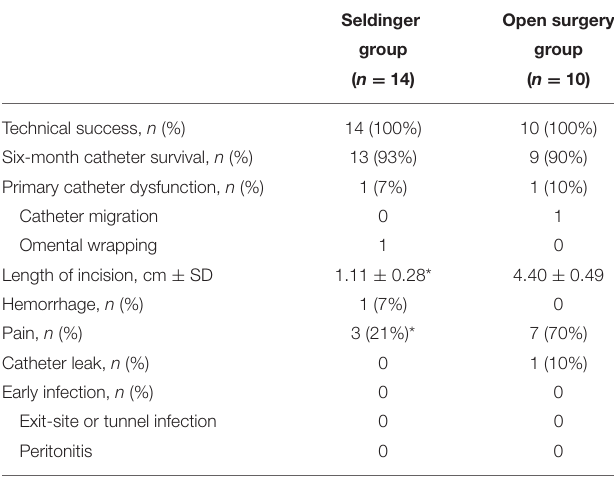
TABLE 2 | Operative characteristics and outcomes of catheter insertion in the two groups.